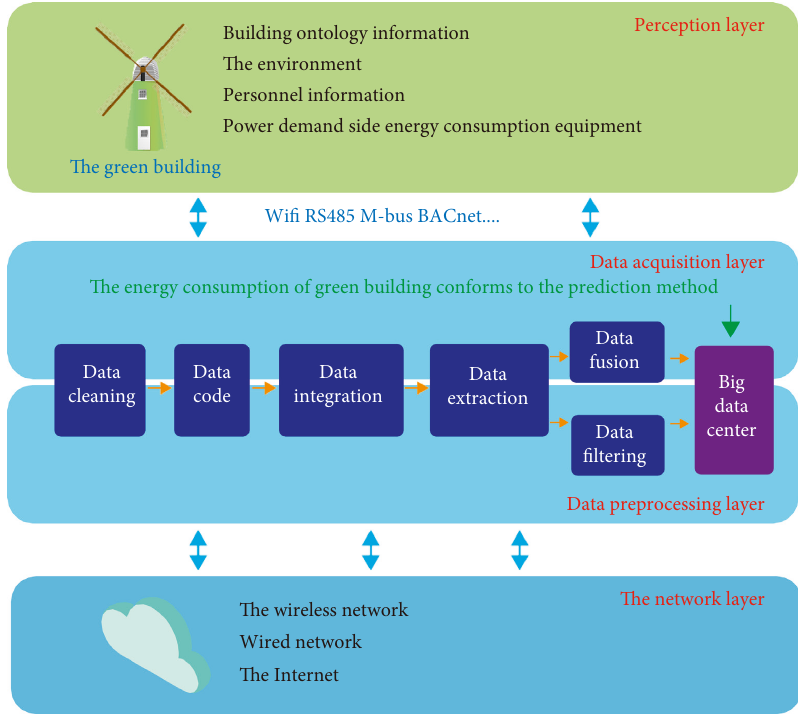
Figure 1: Energy consumption in green